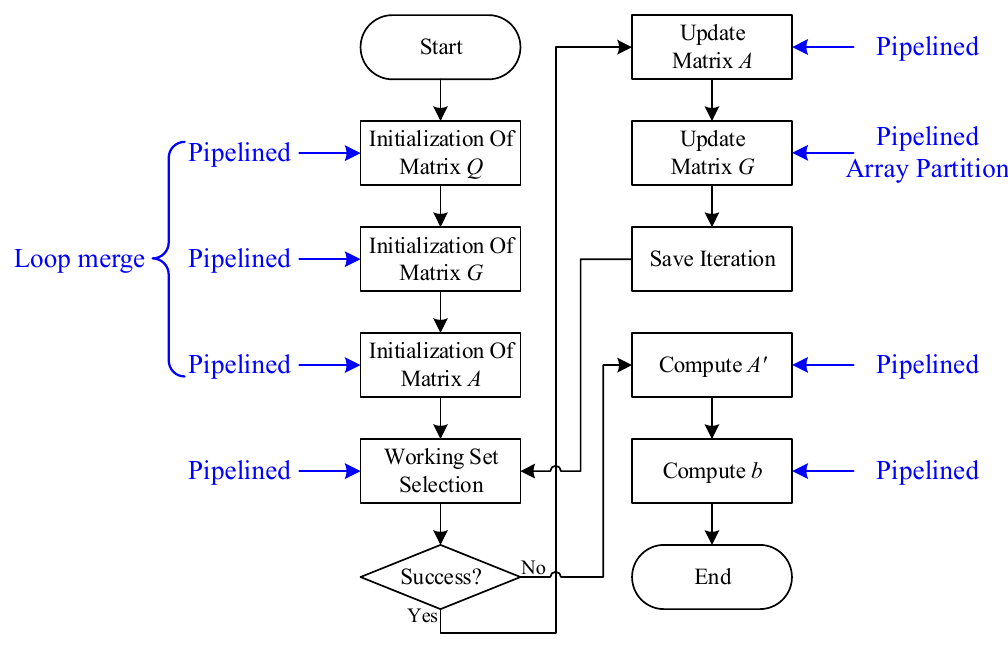
Figure 11. Diagram of flow chart with optimization. Table 3. Latency at di ff erent optimization